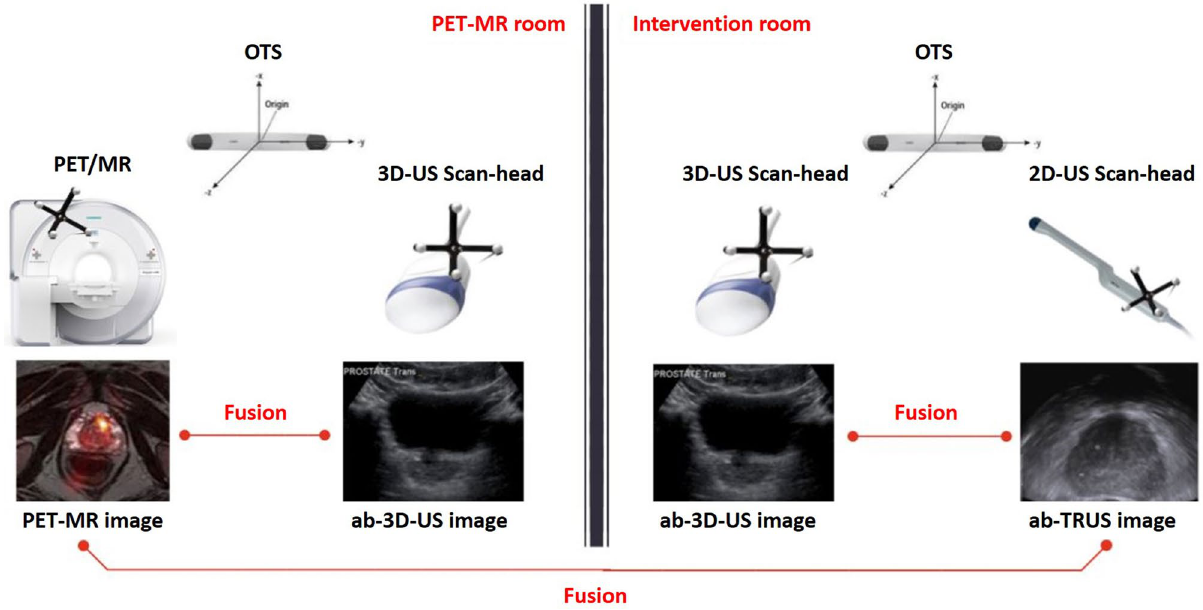
Figure 1. General workflow of the system: an ab-3D-US image is taken immediately after the PET/MR imaging. The transformation between the ab-3D-US and the PET/MR image modality can then be